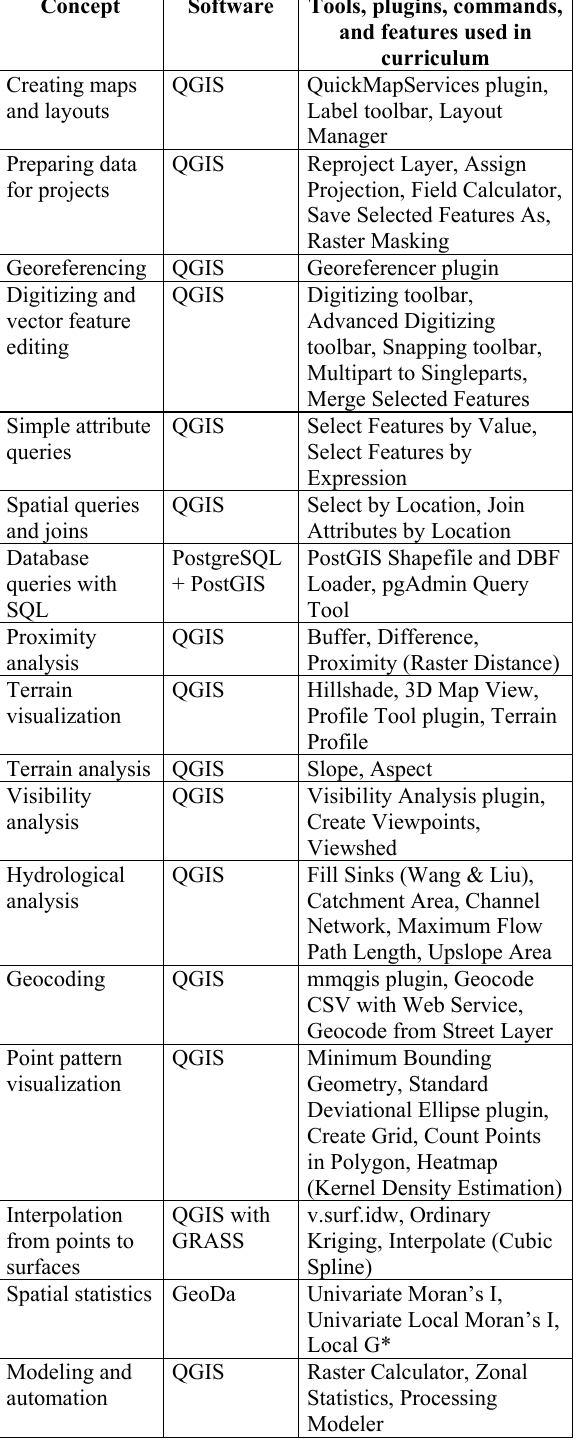
Table 1 . FOSS tools used for teaching GIS